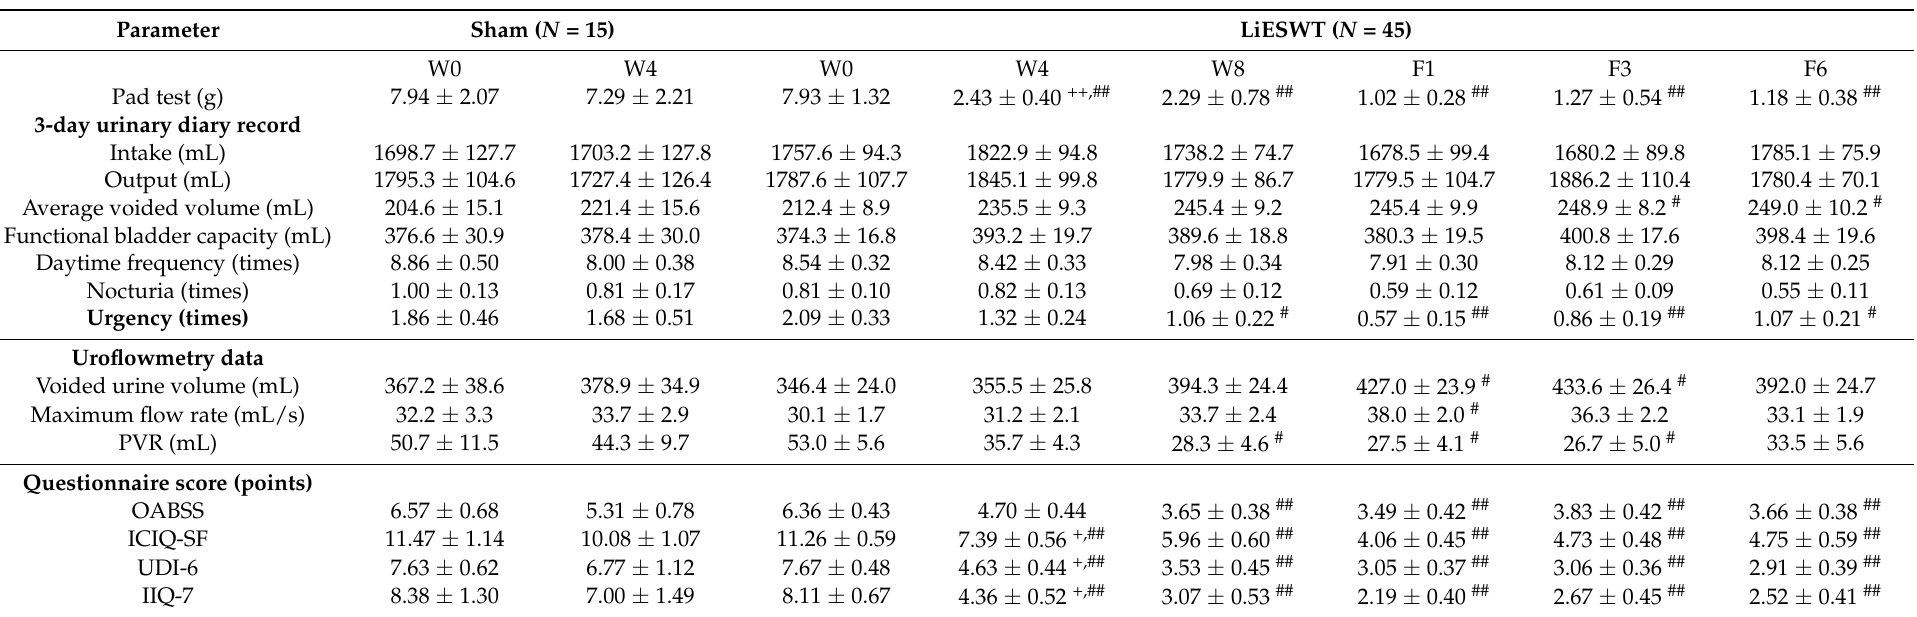
Table 3. Urodynamic parameters and questionnaire score of study population for stress urinary incontinence